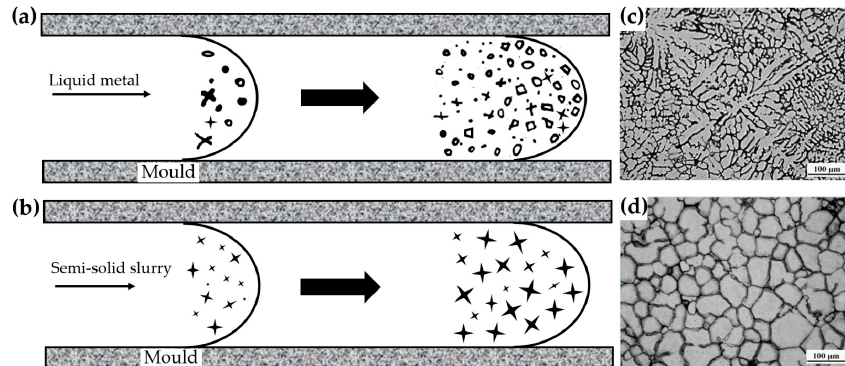
Figure 3. Diagrams of the flow state in a thin channel of ( a ) liquid metal [85] and ( b ) semi-solid slurry [64]. Microstructure of 7075 Al alloy fabricated by ( c ) conventional casting and ( d ) rheocasting [73], with permission from Elsevier, 2019.